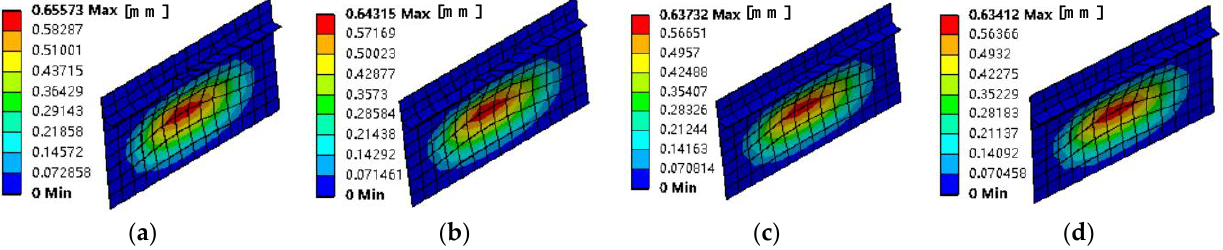
Figure 9. Response diagram of stiffened plate with variable thickness. ( a ) 2 mm thickness. ( b ) 3 mm thickness. ( c ) 4 mm thickness. ( d ) 5 mm thickness.